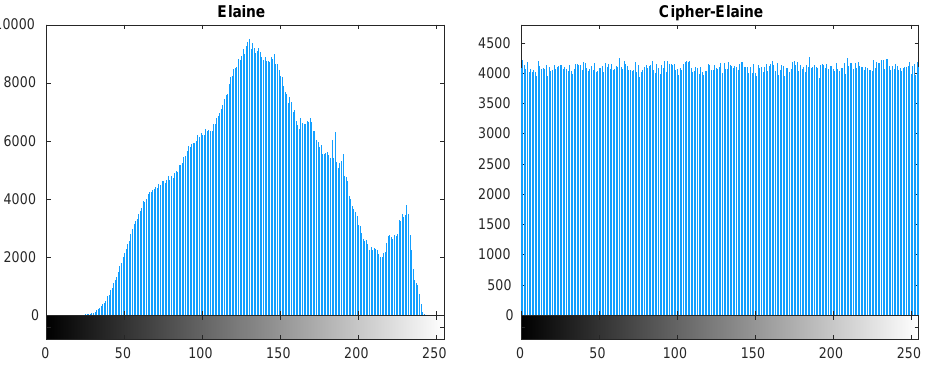
Figure 7. Histograms of two plain images and their corresponding cipher images.